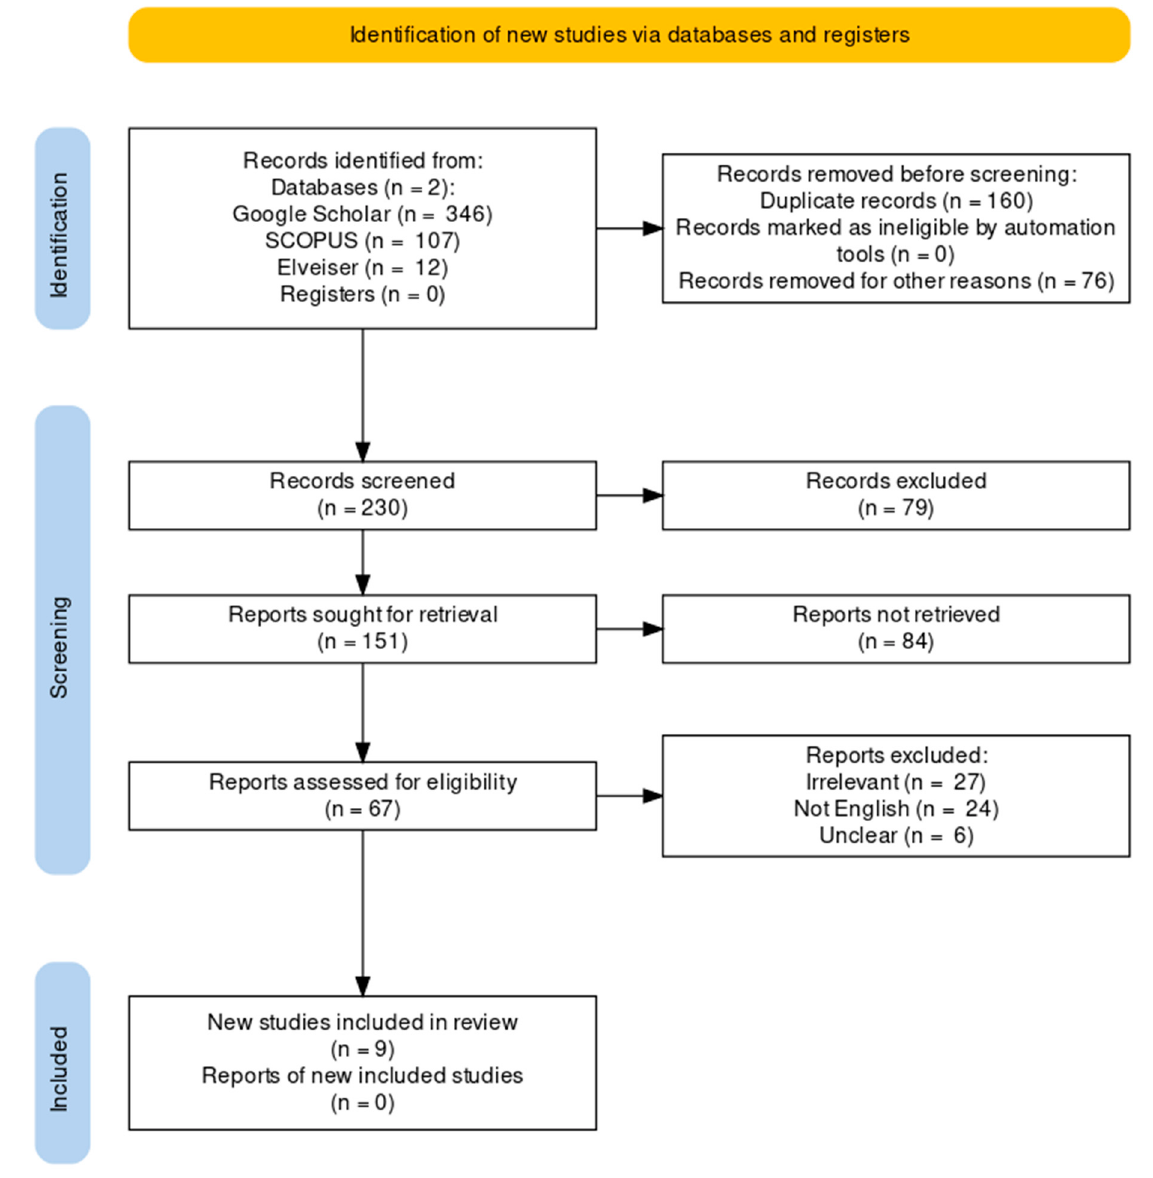
Figure 1. Research methodology flowchart.